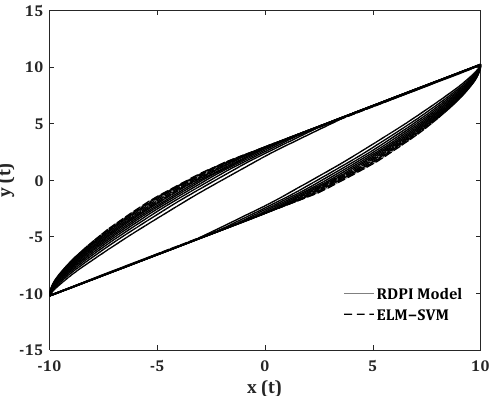
Figure 15. Simulation of hysteresis loops for the RDPI model [39] under harmonic input signals with variant frequencies by ELM − SVM model .